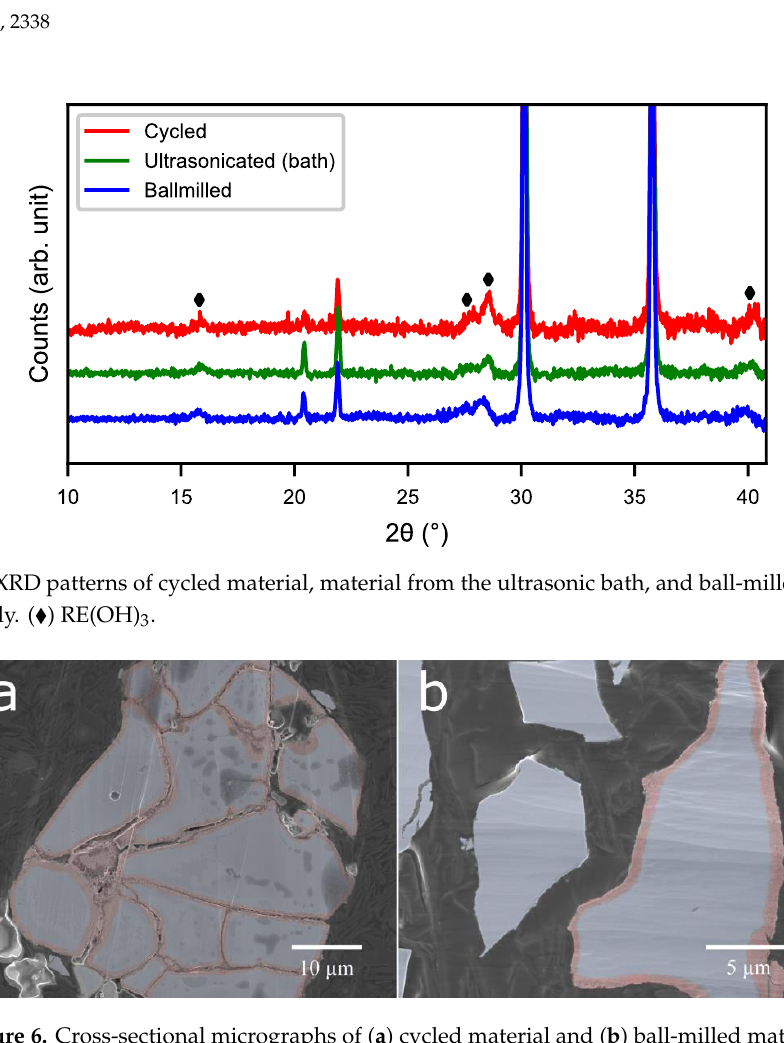
Figure 6. Cross-sectional micrographs of ( a ) cycled material and ( b ) ball-milled material.